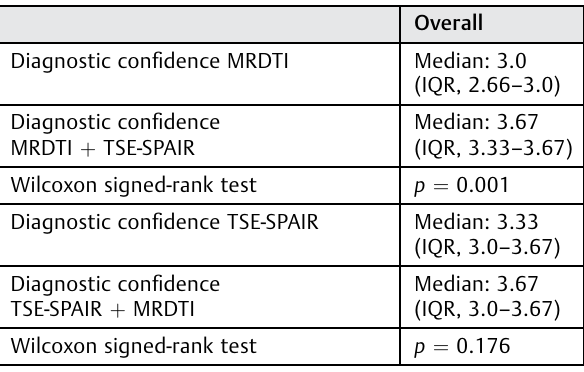
Table 3 Overall diagnostic con fi dence MRDTI and MRDTI þ TSE- SPAIR sequences and vice